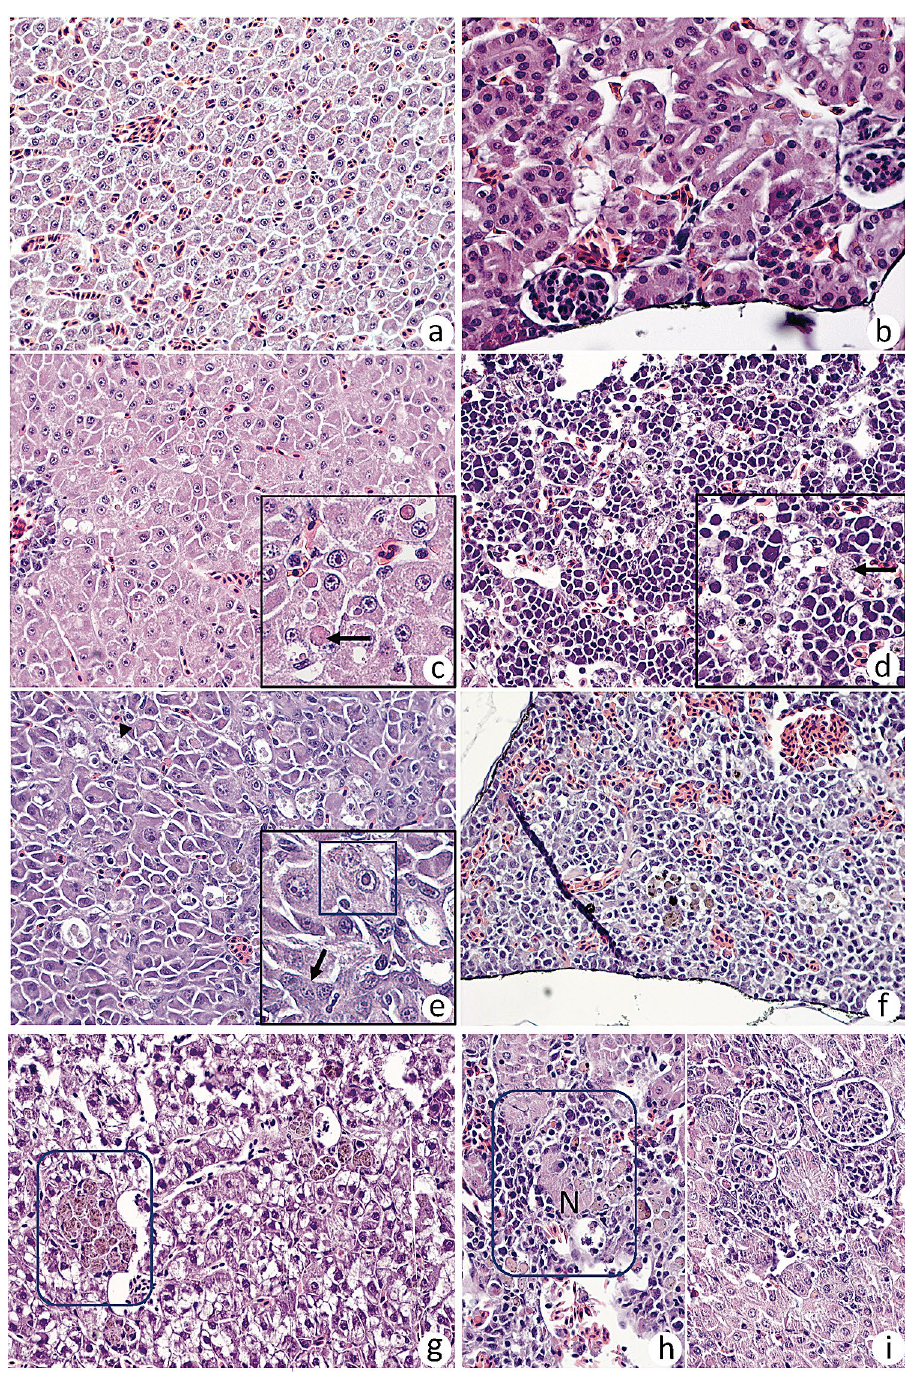
Figure 3. Histopathological changes in different organs over the course of infection. ( a ) Liver and ( b ) kidney prior to challenge showing mild congestion. ( c ) Liver, 3 dpc showing anisocytosis, prominent nucleoli and small droplets in hepatocyte cytoplasm (insert, arrow). Mild perivascular cuffing (arrowhead). ( d ) Kidney, 3 dpc with swollen endothelial cells containing an amorphous substance and endothelial cells fill the sinusoidal lumen (arrow, insert). ( e ) Liver, 12 dpc, with anisocytosis of hepatocytes and anisokaryosis. Prominent karyomegaly with prominent nucleoli consisting of bi- and multinucleated hepatocytes (insert). ( f ) Spleen, 12 dpc, deposition of intracellular pigment in the parenchyma. ( g ) Liver, 17 dpc, focal accumulation of brownish pigment hepatocyte cytoplasm and with vacuolated hepatocytes. ( h ) Kidney, 17 dpc, with focal, interstitial necrosis (N) and moderate infiltration of lymphocytes. ( i ) Kidney, 17 dpc, inflammatory foci around glomeruli with mild thickening of the vascular structure with deposition of amorphous substance along basement membranes. ( j ) Brain, 32 dpc, vacuoles in basal parts of the brain, pyknotic nuclei inside the circle and with macrophage-like cells. ( k ) Brain, 33 dpc, foci with increased number of inflammatory cells, also seen around arrow with increased number of inflammatory cells in white